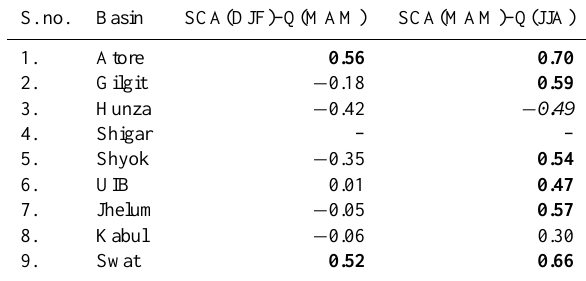
Table 13. Correlation coefficients between the seasonal snow cover area (SCA) for spring (MAM) and winter (DJF) with the discharge (Q) of the summer season (JJA). Note: values significant at the 95% level are marked in bold, and at the 90% level in italic. The Shigar gauging site is no longer operational, so